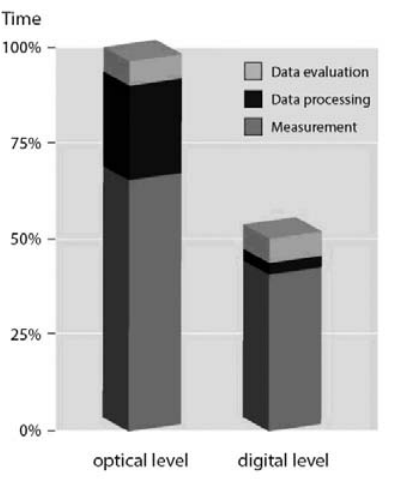
Fig. 1. Work time saving with optical and digital